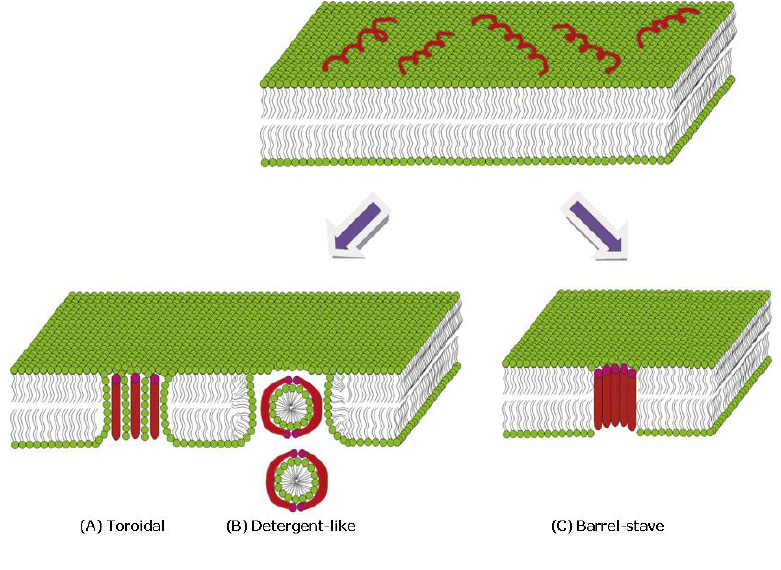
Figure 4. Proposed modes for membrane permeabilization by AMPs: ( A ) Formation of a toroidal pore, where the peptide as well as the detergent head groups face the